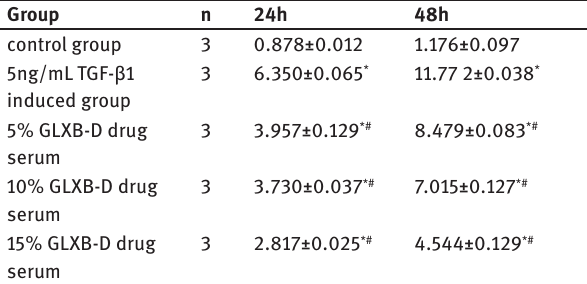
Table 3: The effects of different concentrations of GLXB-D drug serum on the expression of Collagen III of A549 cells (n=3, x±s). Group